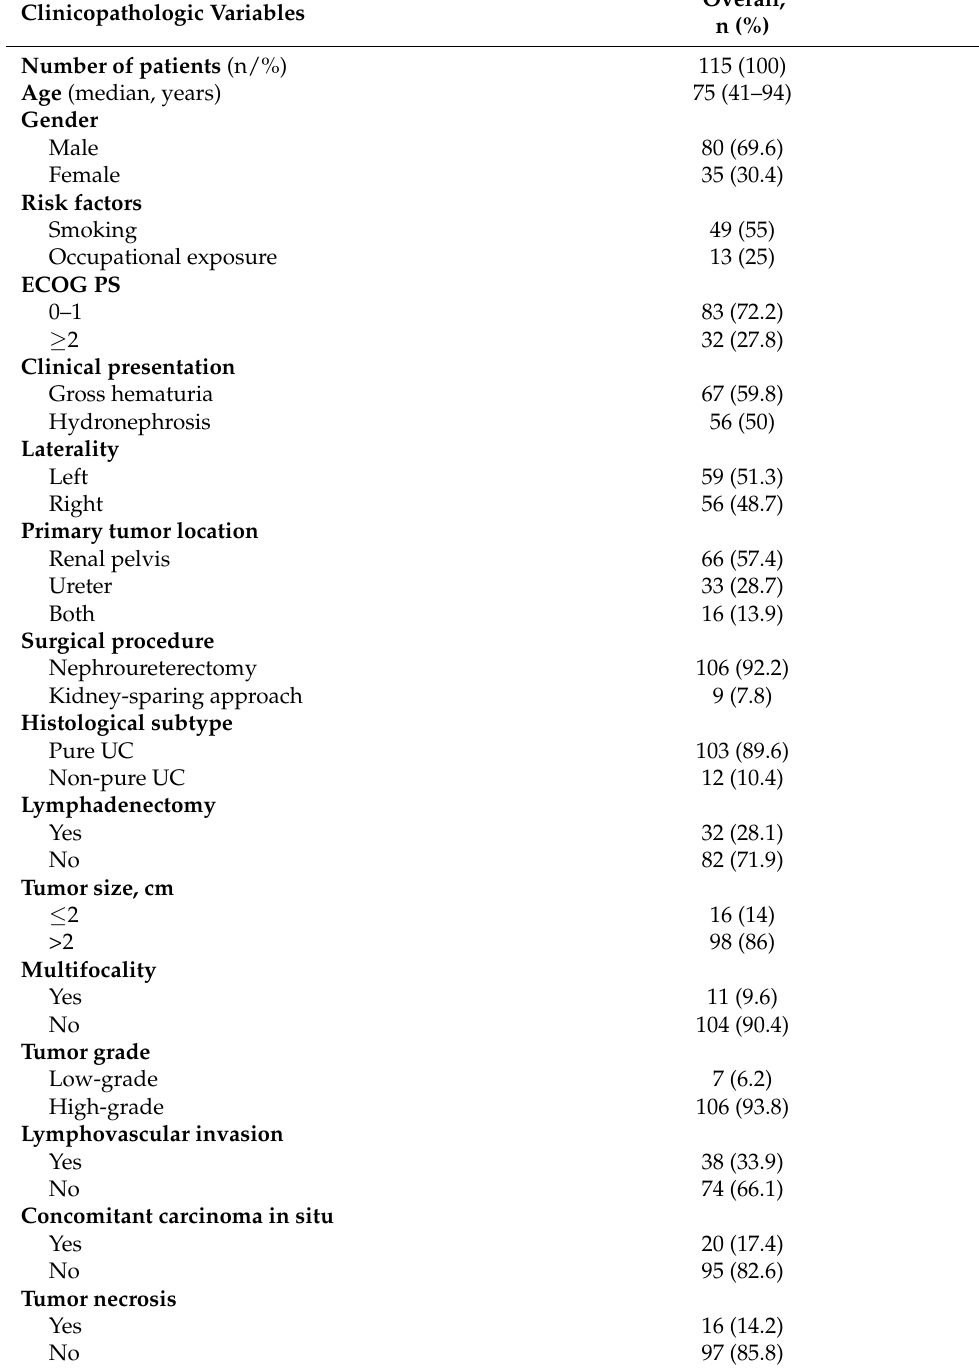
Baseline clinicopathologic characteristics of patients with upper tract urothelial carcinoma